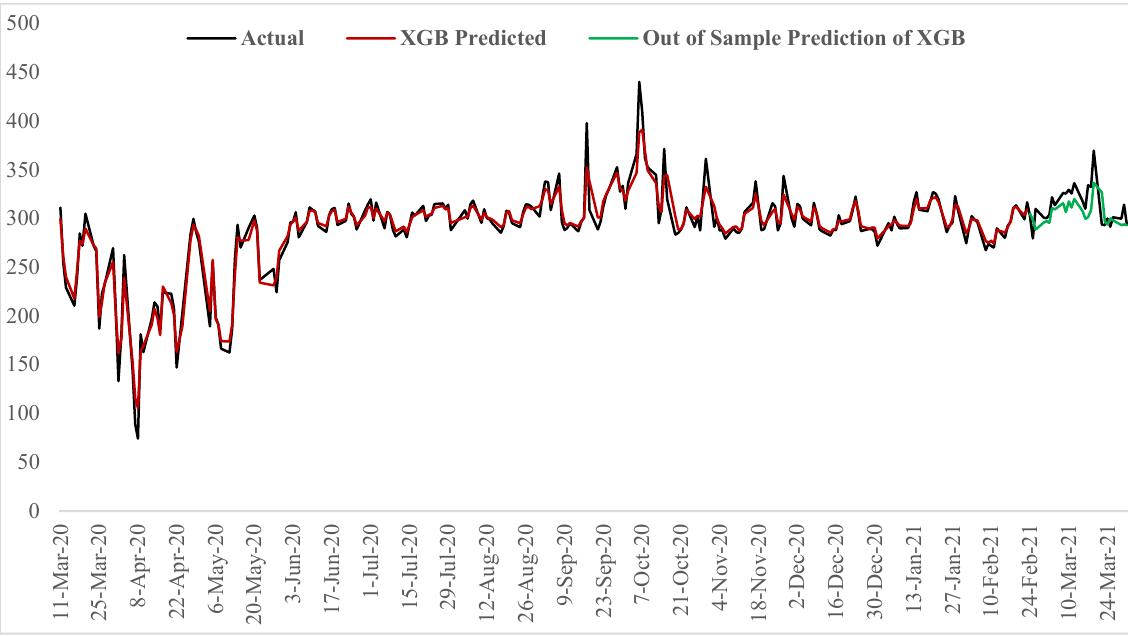
Figure 8. Actual and predicted values in the pandemic period.